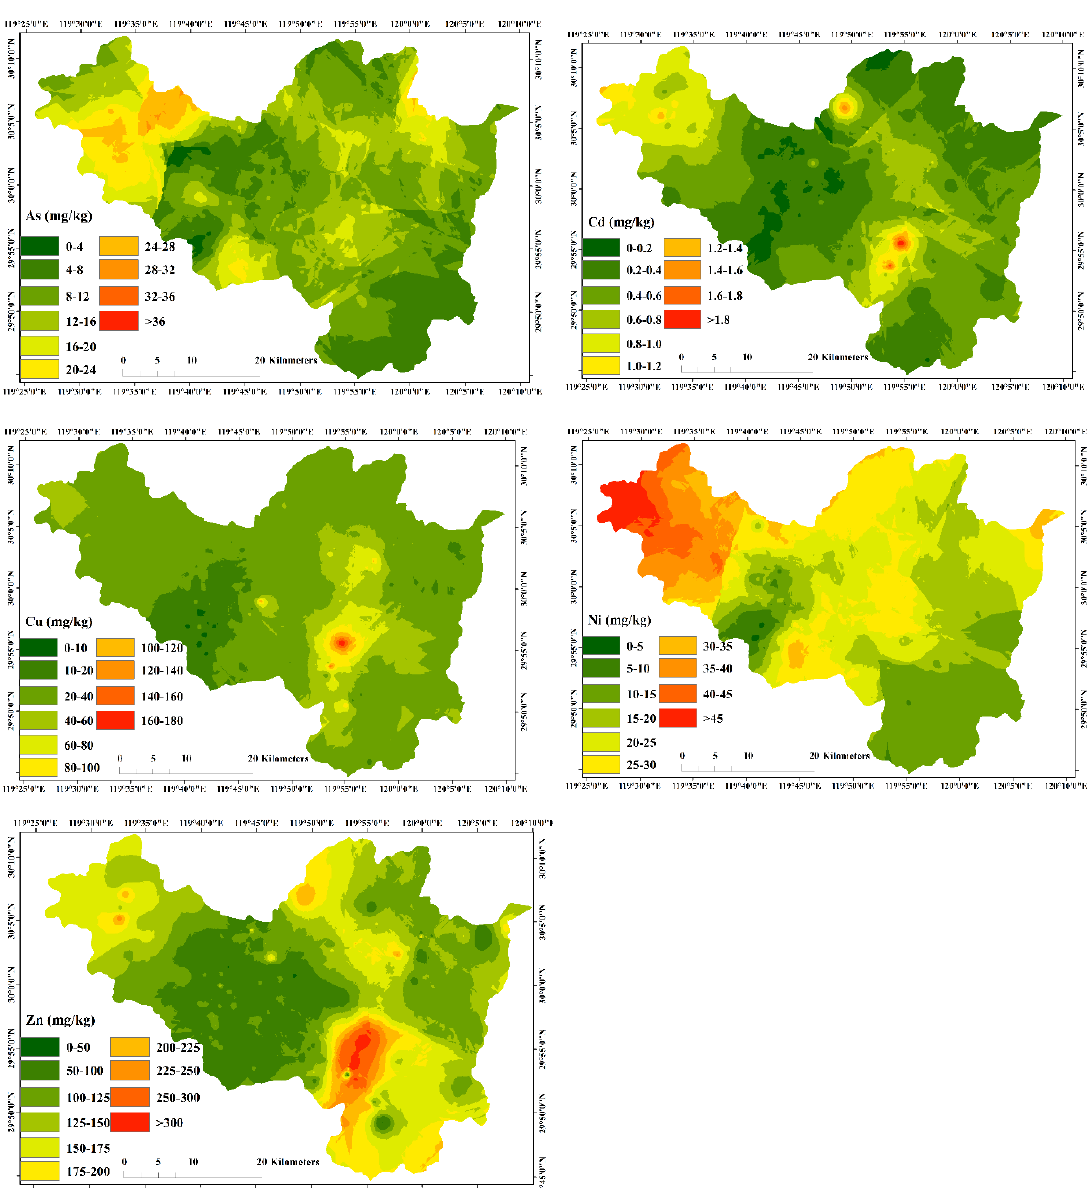
Figure 9. PTE maps produced by model averaging (right column) algorithms.